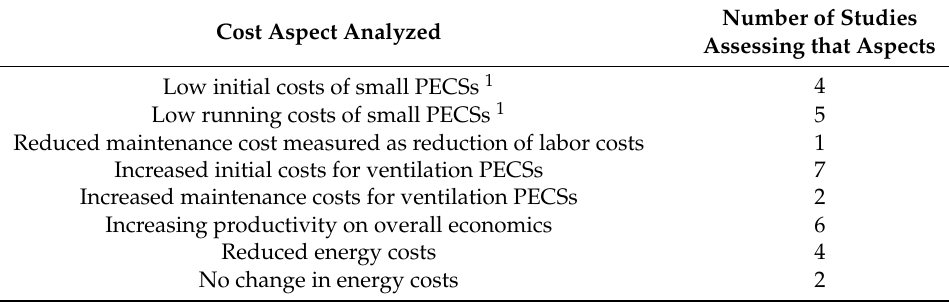
Table 1. Summary of cost aspects analyzed in publications about